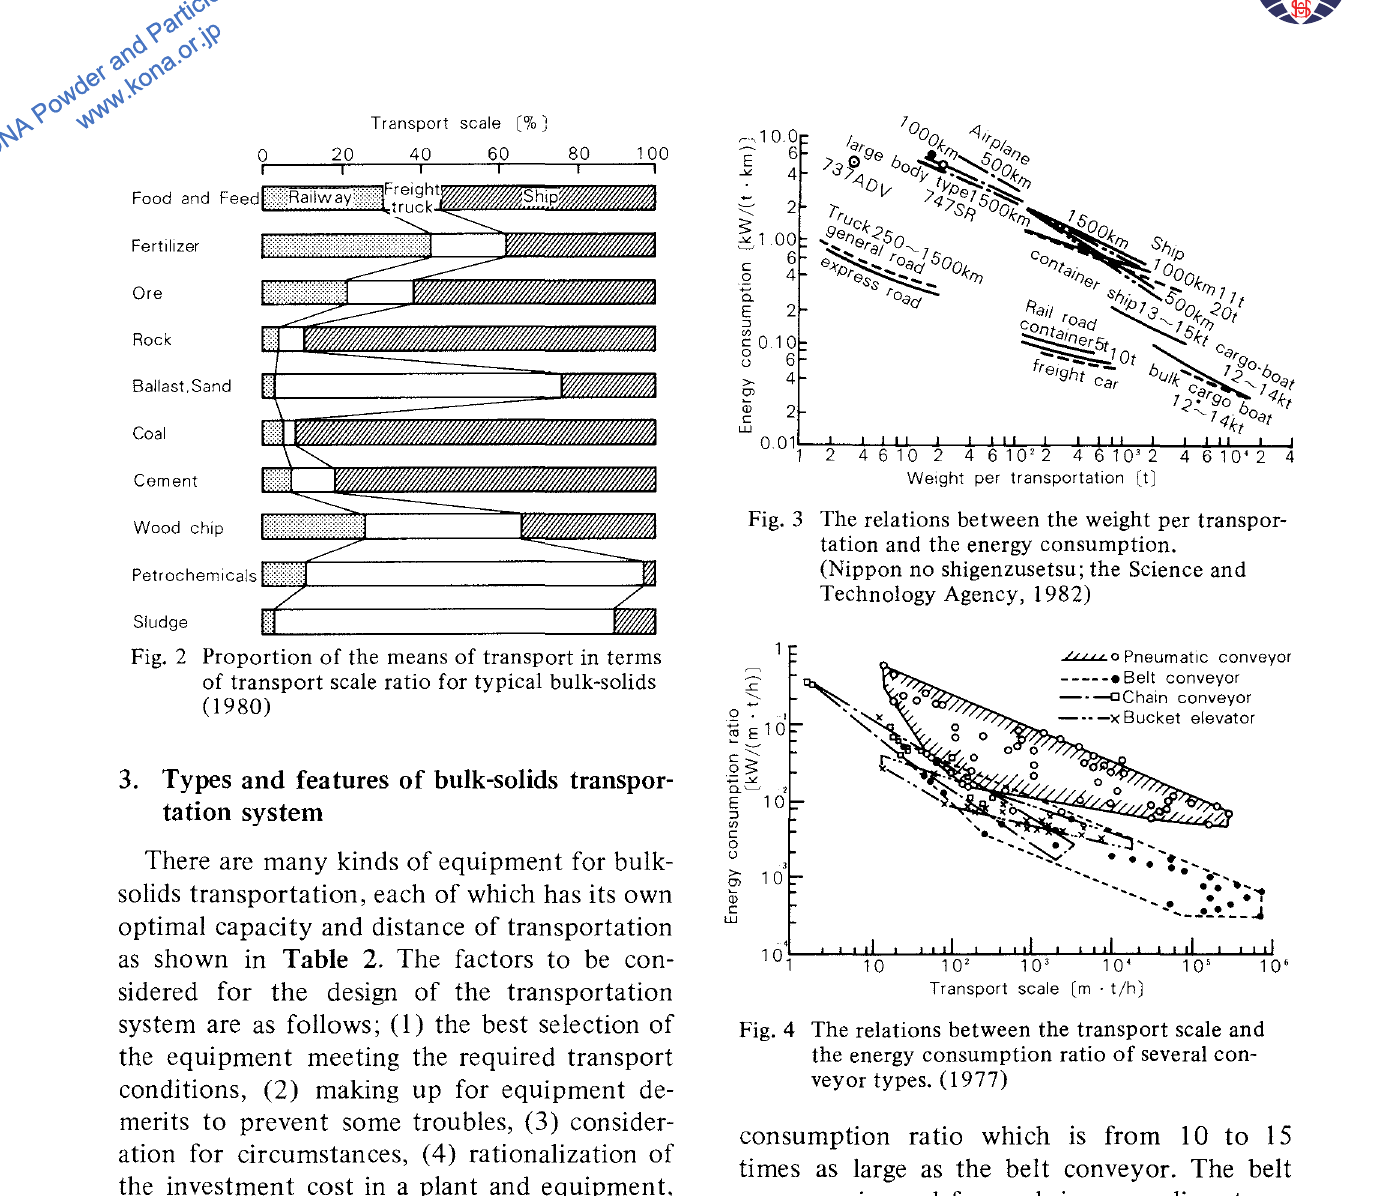
Fig. 3 The relations between the weight per transpor tation and the energy consumption. (Nippon no shigenzusetsu; the Science and Technology Agency, 1982)